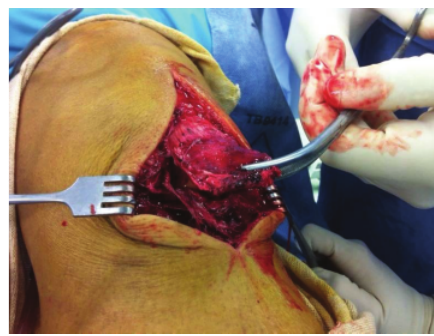
Figure 2: Intraoperative clinical picture showing avulsed patellar tendon from tibial tuberosity.